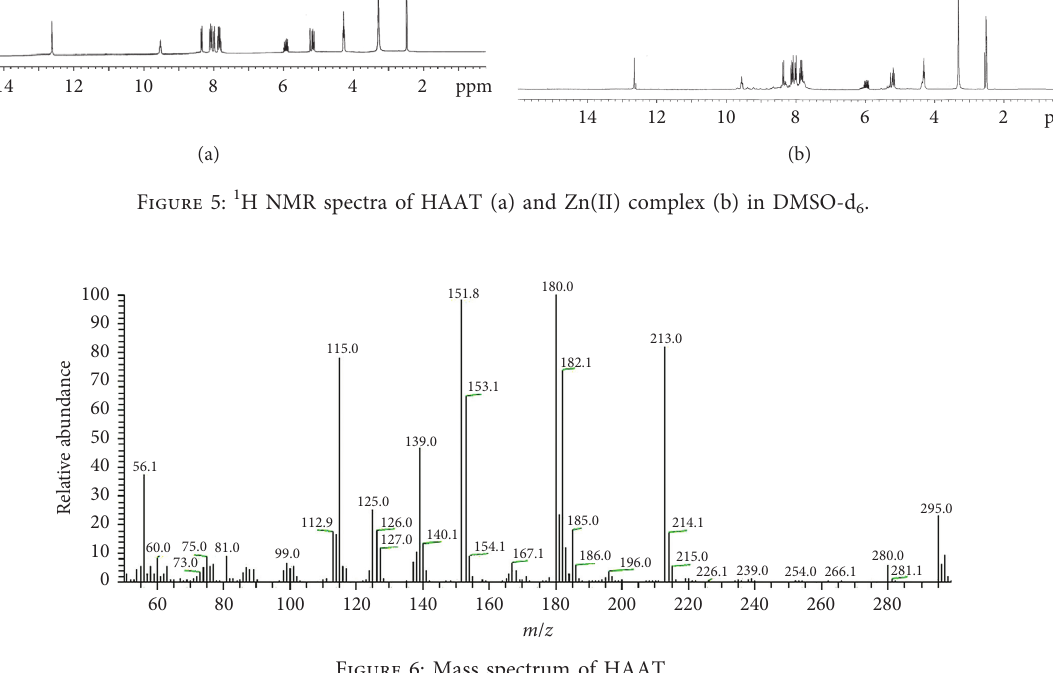
Figure 6: Mass spectrum of